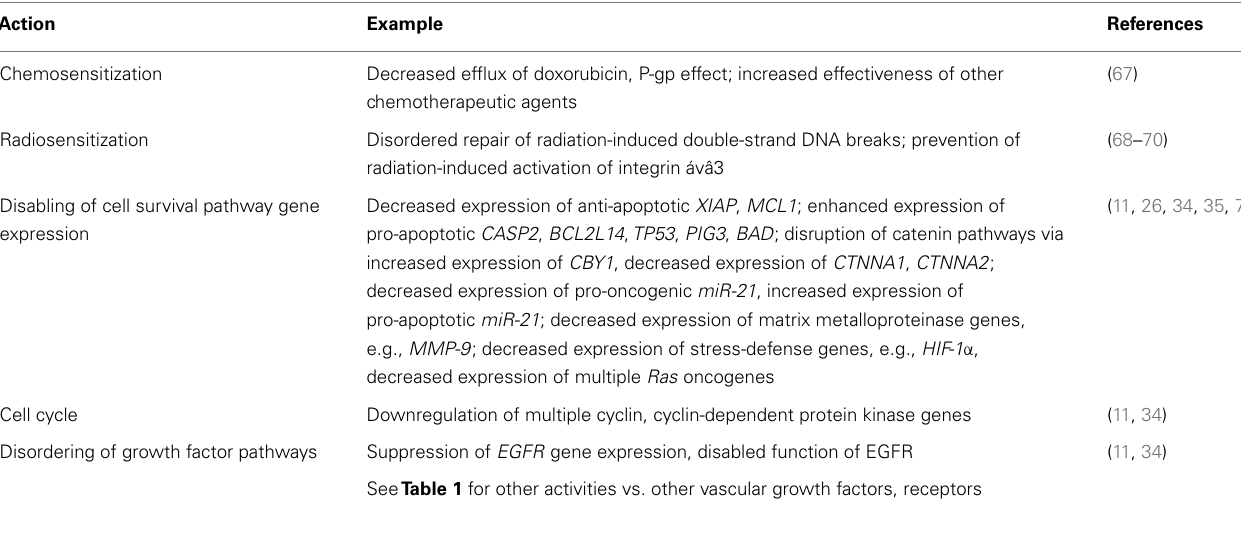
Table 2 | Mechanisms of selected cancer chemotherapeutic actions of Nanotetrac